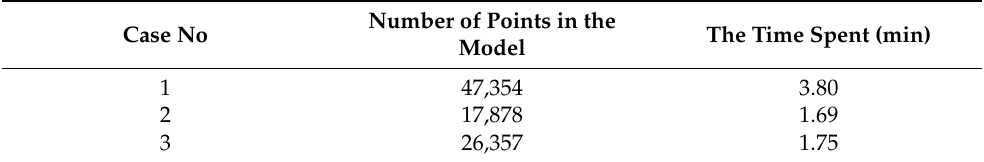
Table 4. Time consumed for different size point cloud registrations.